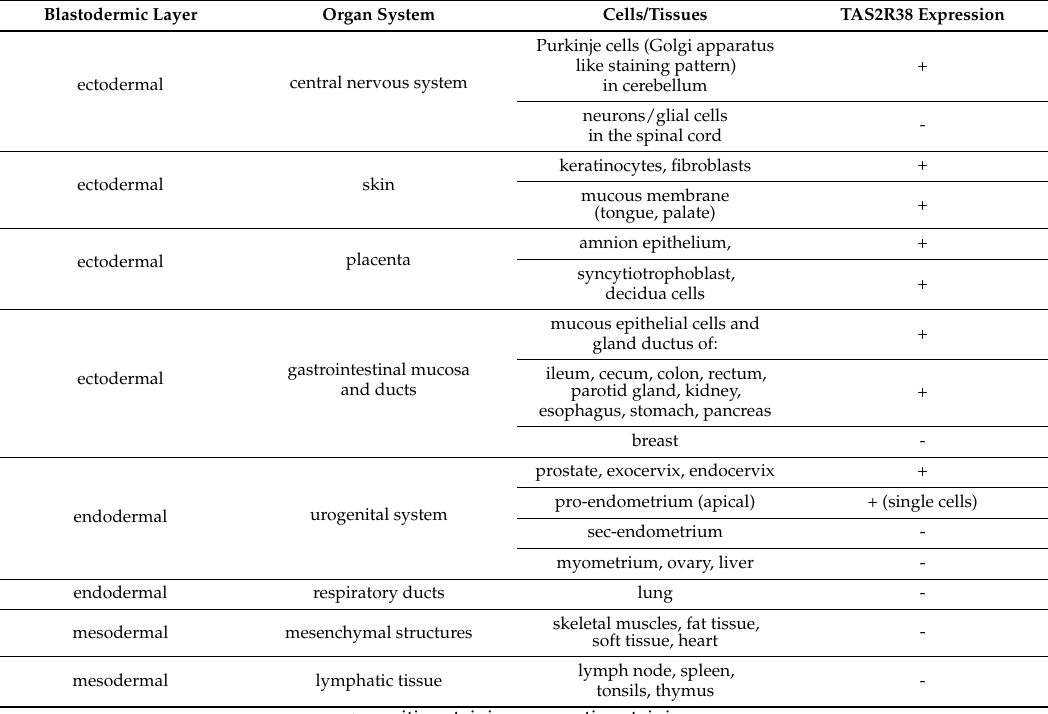
Table 1. Summary of TAS2R38-positive and -negative human tissues.